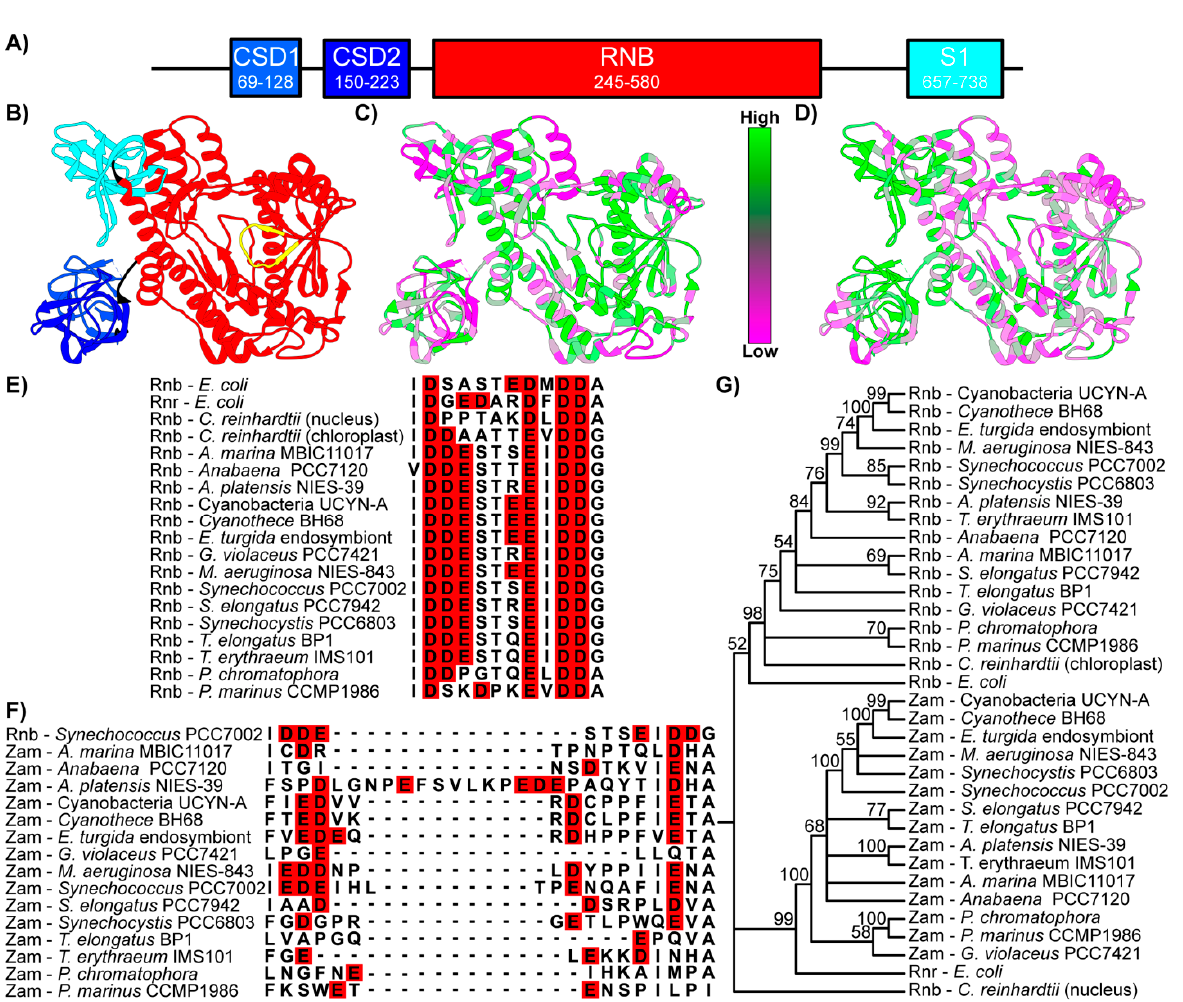
Figure 1. Domain architecture and conservation of Zam. ( A ) Map of PCC 7002 Zam domains as identified by Pfam. Each predicted domain of Zam corresponds to a domain found in E. coli Rnr. ( B ) E. coli Rnr crystal structure with domains color coded to match Zam domain map. The active site shown in alignments is indicated in yellow. ( C ) Cyanobacterial Rnb protein conservation mapped to E. coli Rnr crystal structure. Conservation is observed across the protein but is most concentrated around the RNB domain active site. ( D ) Cyanobacterial Zam conservation mapped onto E. coli Rnr crystal structure. Most conservation is observed in the RNA binding domains (CSD1, CSD2, S1). Low conservation is observed around the active site. ( E ) Multiple alignment of cyanobacterial Rnb protein active sites with outgroups shown as reference. Aspartic and glutamic acid residues color coded in red. ( F ) Multiple alignment of zam protein active sites. Aspartic and glutamic acid residues color coded in red. Active site regions were identified by alignment with active site region shown in Figure 1E. The sequence of Rnb from PCC 7002 is included to represent functional RNB domain active sites. ( G ) Bootstrap consensus tree of cyanobacterial Rnr, cyanobacterial Rnb, and outgroup homolog protein sequences. Cyanobacteria Rnb genes cluster as a distinct group along with chloroplastic Rnb genes and the E. coli Rnb gene. Zam proteins form their own cluster with E. coli Rnr. An Rnb domain containing protein from the nuclear genome of C. reinhardtii is provided as an outgroup.